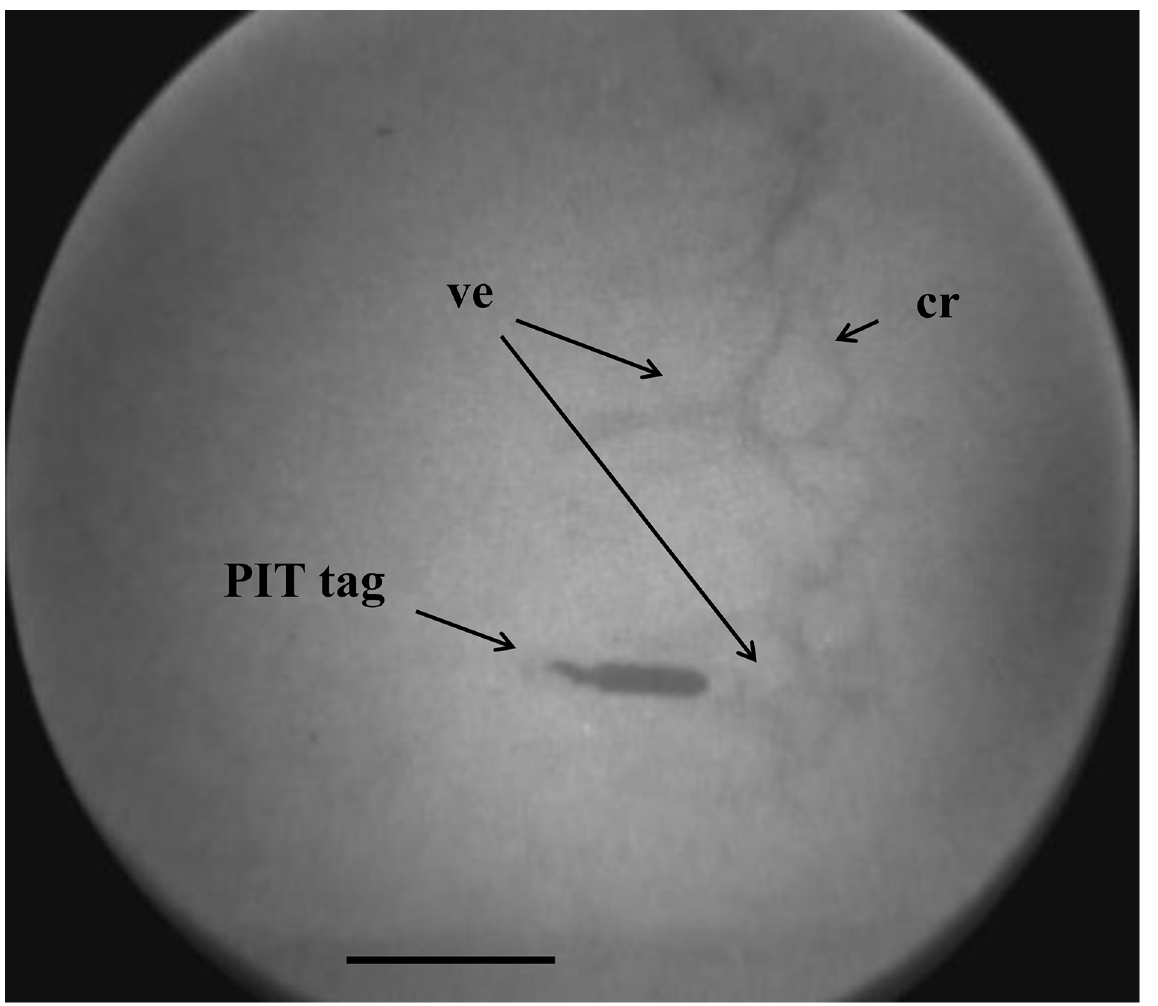
Fig 2. X-ray photograph of sea cucumber tagged in the aquapharyngeal bulb. PIT tags successfully implanted in the aquapharyngeal bulb through a deployed tentacle lodged themselves in one of the tentacle vesicles (ve) close to the calcareous ring (cr). Scale bars represent 2